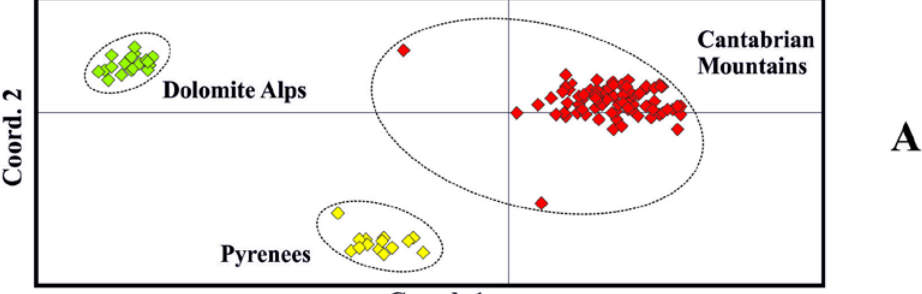
Figure 2. Two-dimensional ordination of principal coordinate (coord.) analysis of 123 individuals of G. lutea ( A ) and the subset of 88 individuals of G. lutea var. aurantiaca from the Cantabrian Mountains ( B ) using Jaccard’s genetic distance between